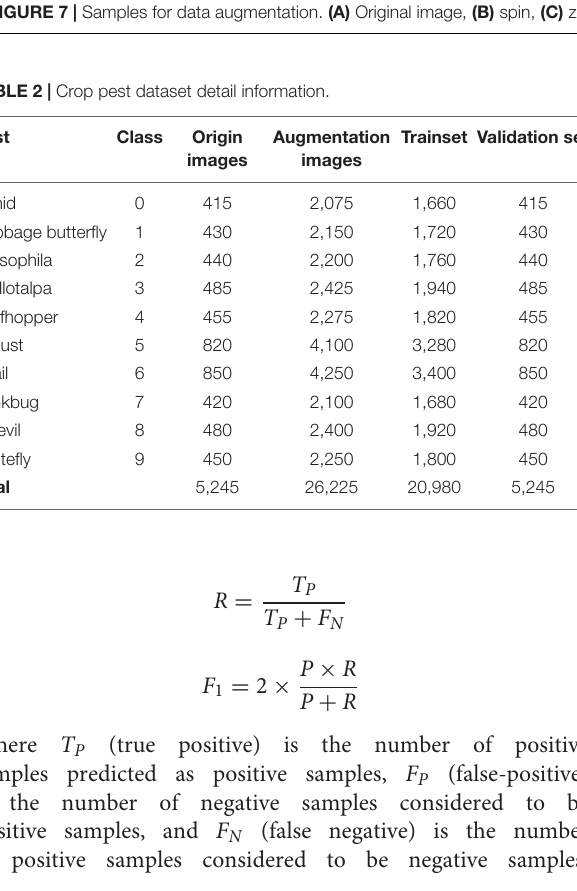
FIGURE 7 | Samples for data augmentation. (A) Original image, (B) spin, (C) zoom, (D) Gaussian noise, and (E) color jitter.